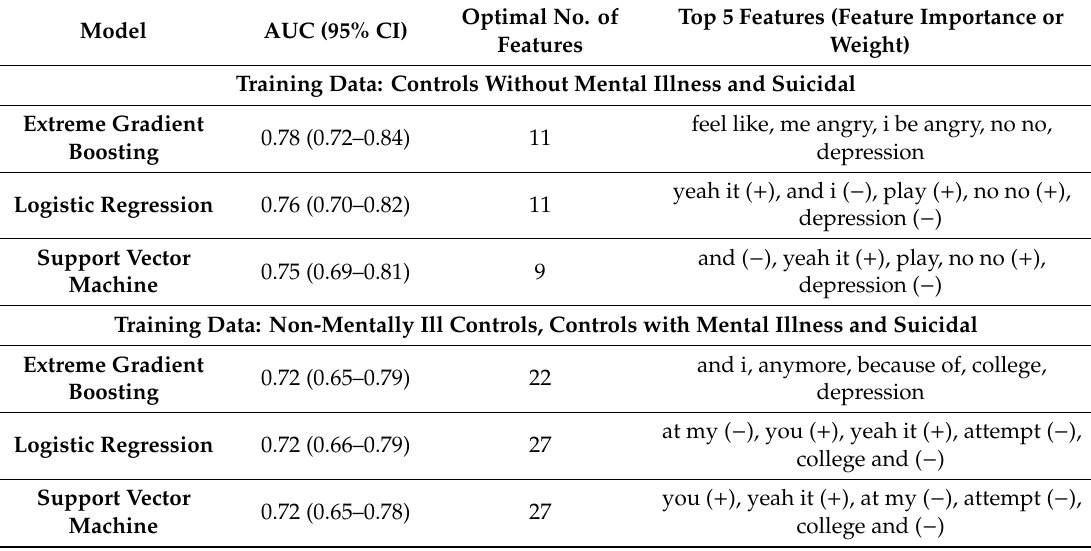
Table 5. Model performance predicting suicidal risk in pilot language